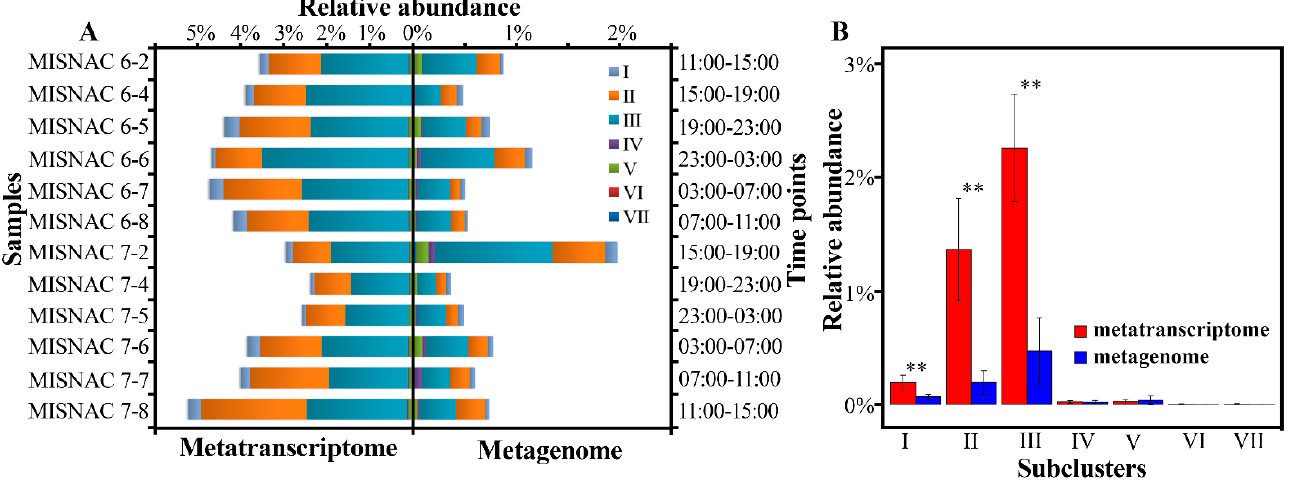
Figure 4. Relative abundance of SAR202 subclusters in metagenomic and metatranscriptomic data for different time periods. Twelve in situ microbial samples were continuously collected at 1022 m depth in the SCS by the MISNAC apparatus. ( A ) Percentages of 16S miTags of each SAR202 sub- cluster in all those extracted from metagenomes and metatranscriptomes are exhibited as their rel- ative abundance. ( B ) The significant difference between metagenomics and metatranscriptomics data in relative abundance for each SAR202 subcluster was verified by t -test. ** represented a significant difference ( p < 0.01).